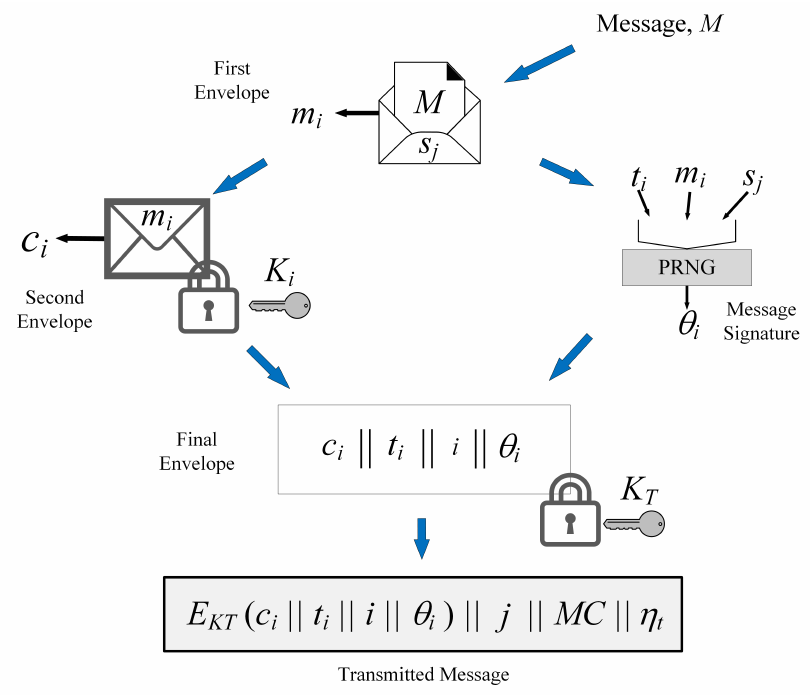
Figure 1. Working of the proposed encryption scheme